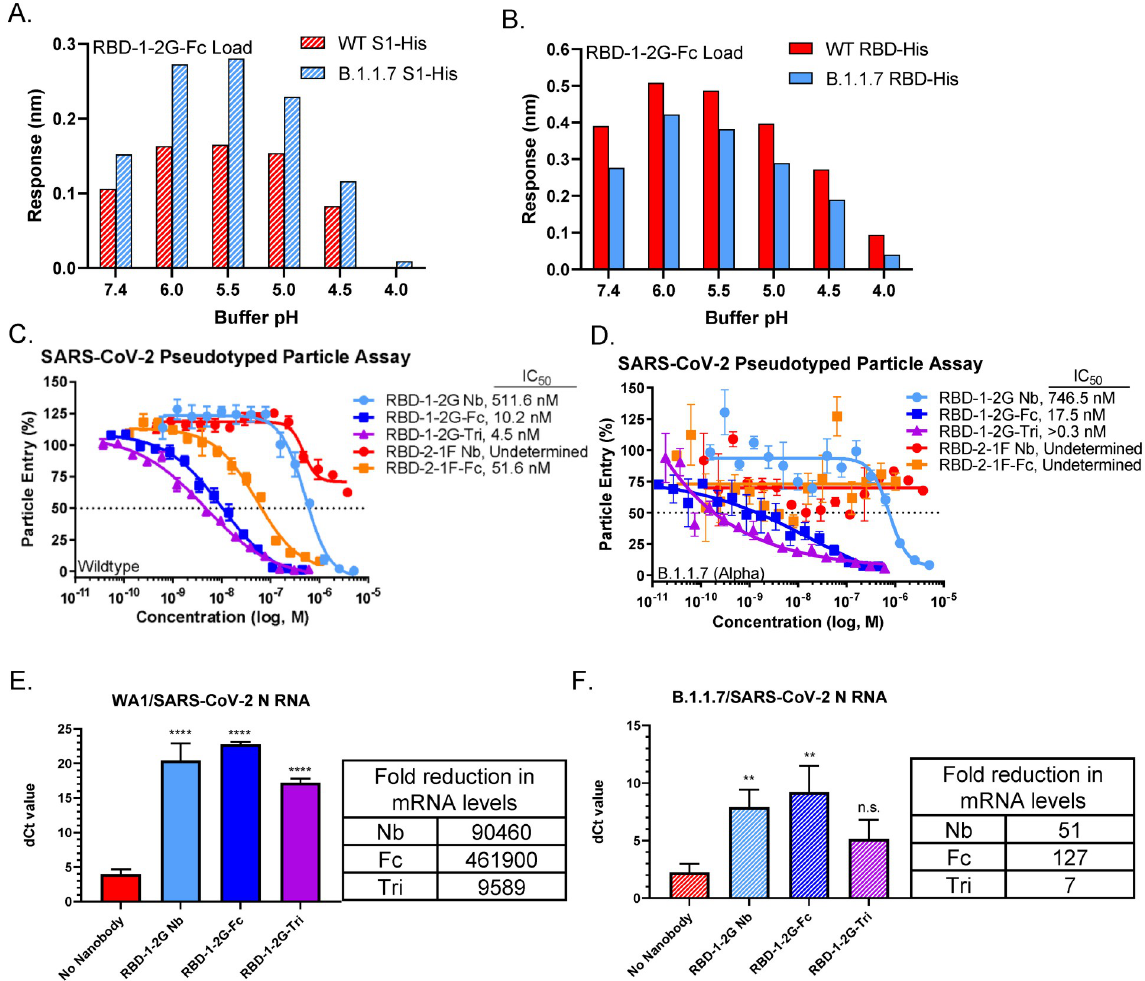
Fig 4. Binding and neutralization of RBD-1-2G to the WT and B.1.1.7 variant (N501Y). (A) Maximum response values reached during the association phase by RBD-1-2G-Fc binding wildtype (WT) and B.1.1.7 (Alpha) variant S1-His. Differences in pH were achieved using PBS (pH 7.4) or 10 mM Acetate buffers with 150 mM NaCl (pH 4 –pH 6.0), all buffers contained 0.1% BSA and 0.02% Tween. (B) Maximum response values reached during the association phase by RBD-1-2G-Fc binding WT and UK variant RBD-His proteins. (C-D) SARS-CoV-2 pseudotyped particle entry assay using HEK293-ACE2 cells as target. Inhibition of WT(C), B.1.1.7 (D) pseudotyped particle treated with various RBD-1-2G and RBD-2-1F formats. Representative biological replicate with n = 2. Technical replicates are n = 3 per concentration, all error bars represent